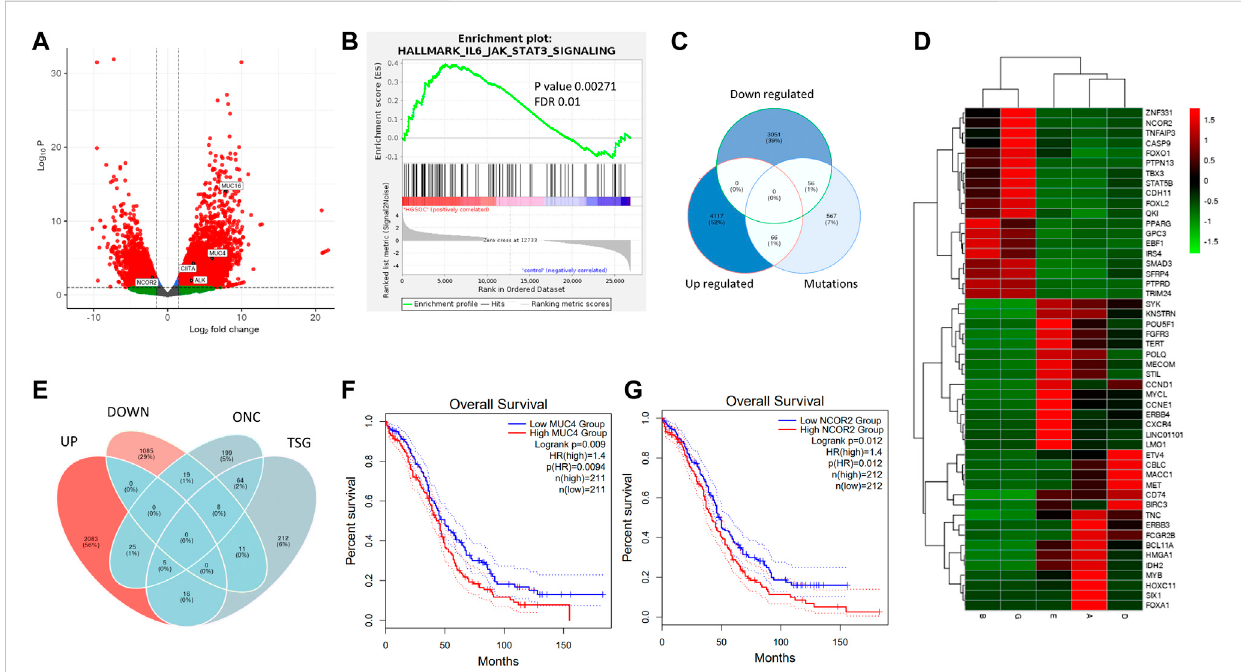
FIGURE 5 Integrated exome and transcriptome analysis of HGSOCs. (A) . Gene expression volcano plot for HGSOCs and highlighted genes represent mutated andsigni fi cantlydifferentiallyexpressedones. (B) .JAK-STATpathwayenrichmentinHGSOCswithpval0.00271andFDR0.01. (C) .Venndiagramshowing number of upregulated, downregulated and mutated genes and their respective intersections. (D) . Heatmap of common downregulated TSGs and upregulated ONCs. (Red showing upregulation and green indicating downregulation) (E) . Venn diagram of differentially expressed genes being ONCs and TSGs in HGSOC. (F, G) Kaplan Meier plots of MUC4 and NCOR2 signifying survival probability between high vs. low expressed groups from GEPIA